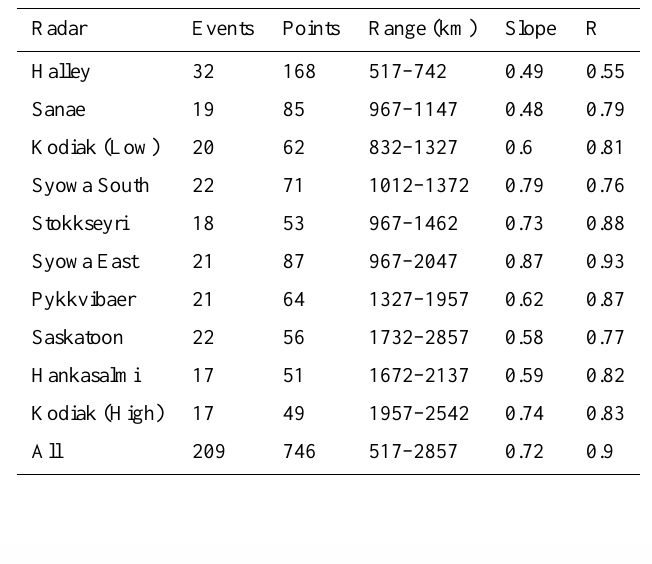
Table 1. Information on number of events and points available, typical ranges, and the slope of the best fit line between SuperDARN and DMSP velocities for various radars